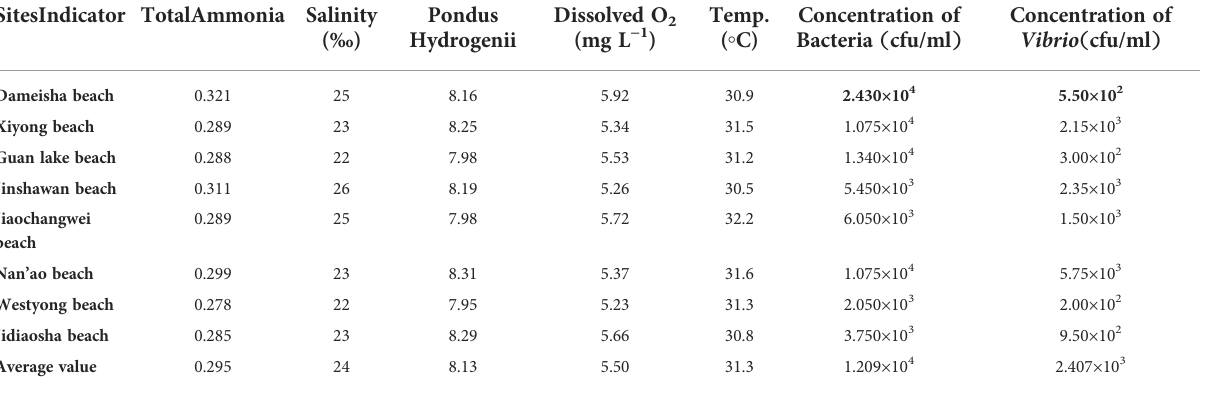
TABLE 3 Physiochemical water parameters of the 8 studied beach.